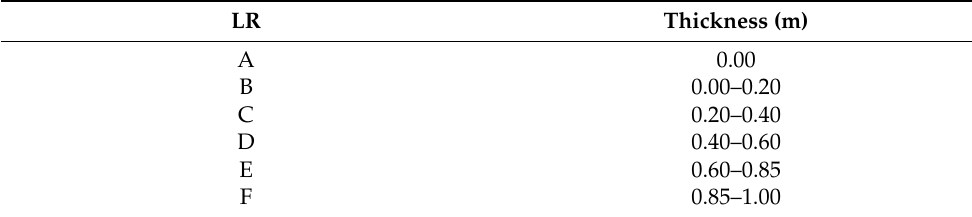
Table 2. Ranking of the Lithological Ratios derived by Equation (1).